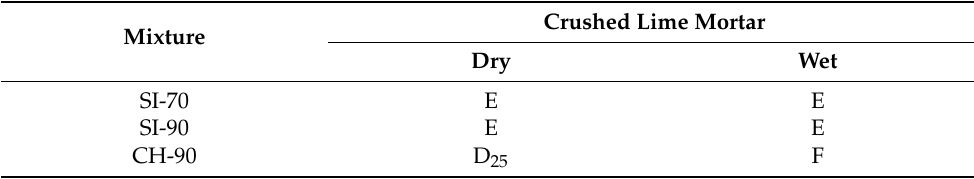
Table 5. Results of injectability with a